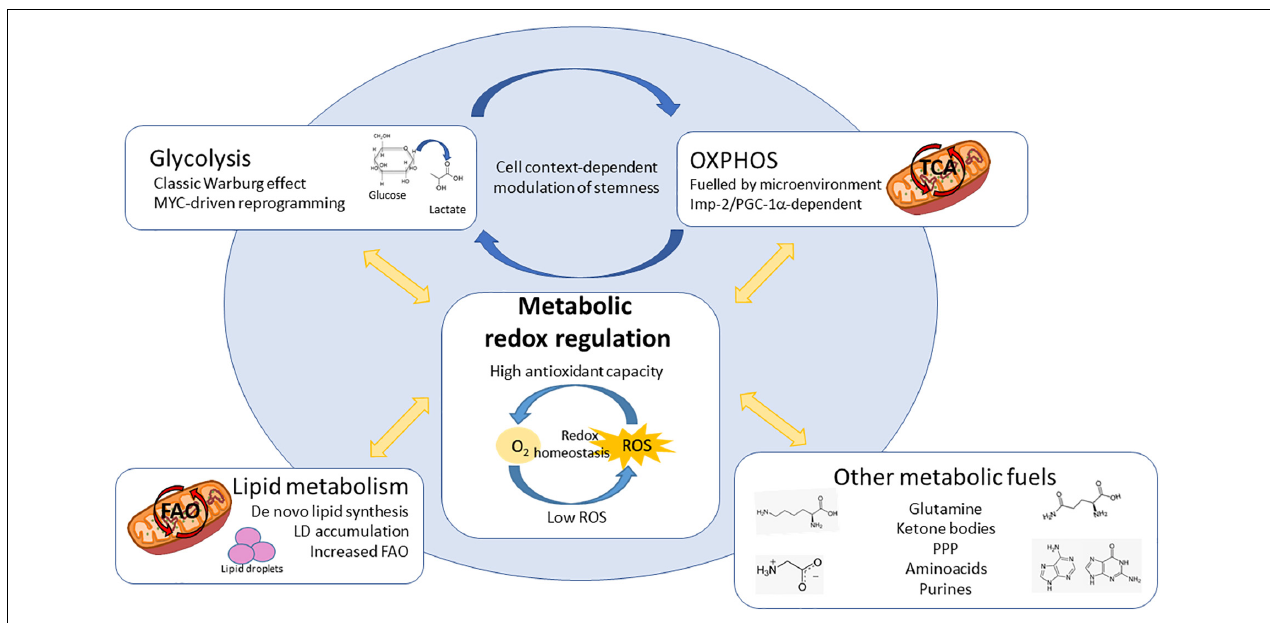
FIGURE 3 | Redox involvement in the different metabolic dependencies described for CSCs. CSCs bear diverse metabolic dependencies in a tumor and context-dependent manner: (1) Aerobic glycolysis, controlled by MYC; (2) OxPhos, fuelled by different microenvironmental substrates and controlled by Imp2 or PGC-1 α ; (3) Lipid metabolism, increasing either fatty acid synthesis and storage in lipid droplets (LDs) or utilization via mitochondrial FAO; (4) CSCs can be dependent on alternative substrates and pathways such as aminoacids, ketone bodies, PPP or purines. Interestingly, the metabolic phenotypes described for CSCs ensure the maintenance of cellular redox state. Keeping redox balance is crucial for CSCs in order to maintain their stemness characteristics, differentiation ability and resistance to chemo and radiotherapy, constituting one of the most important vulnerabilities independently of their origin or cellular context. ROS – reactive oxygen species, OxPhos – oxidative phosphorylation, LDs – lipid droplets, PPP – pentose phosphate pathway, FAO – fatty acid oxidation, TCA – tricarboxylic acid